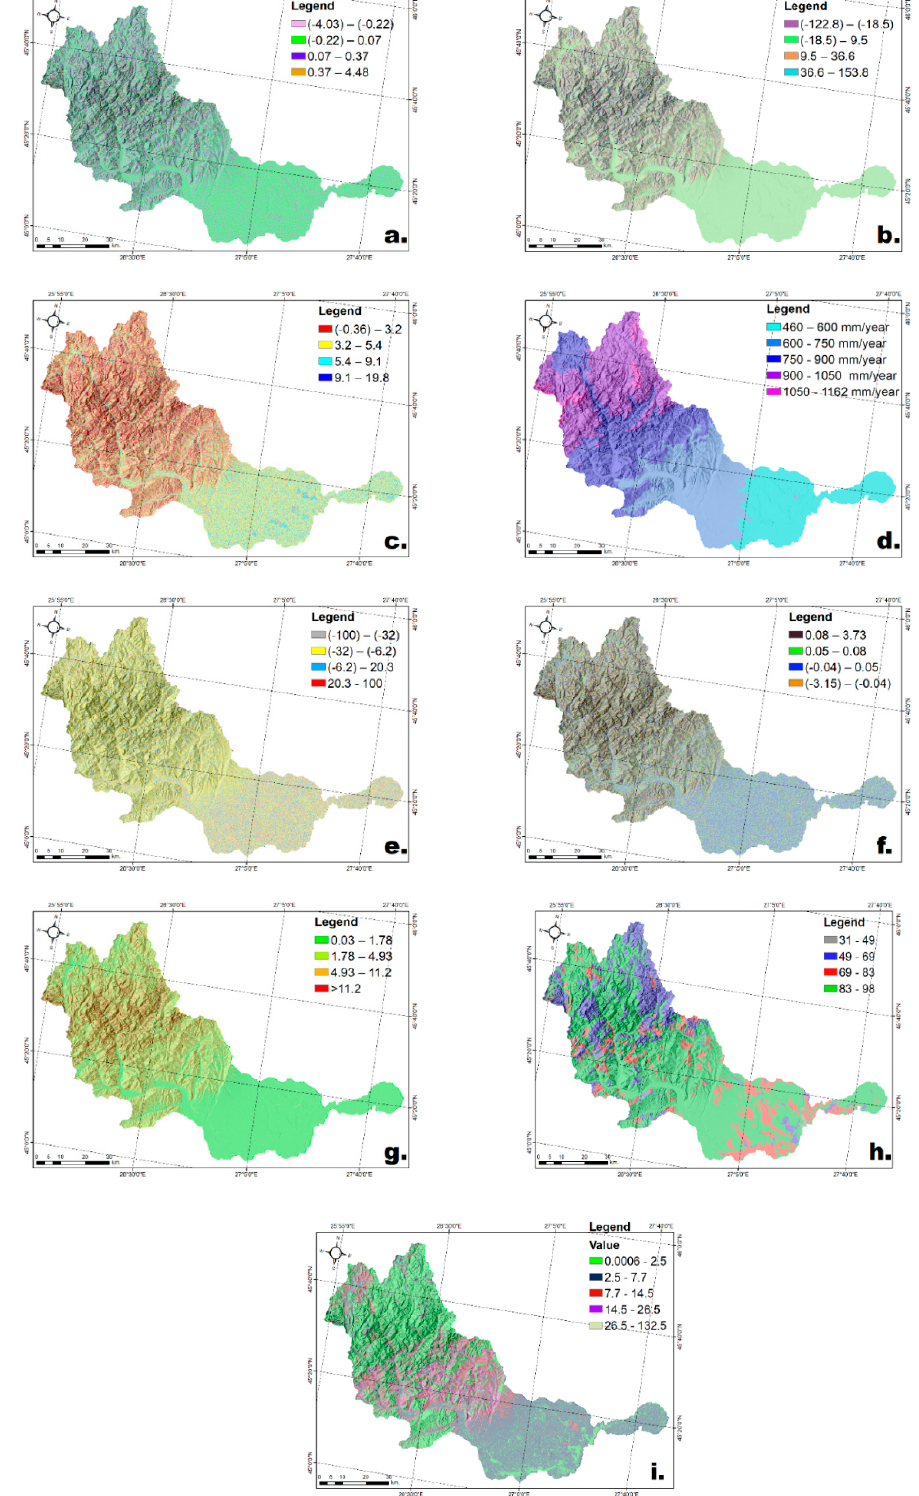
Figure 4. ( a ) Plan curvature, ( b ) Topographic Position Index (TPI), ( c ) Topographic Wetness Index (TWI), ( d ) multi-annual precipitation, ( e ) Convergence Index, ( f ) profile curvature, ( g ) L-S factor, ( h ) curve number, ( i ) soil erodibility by